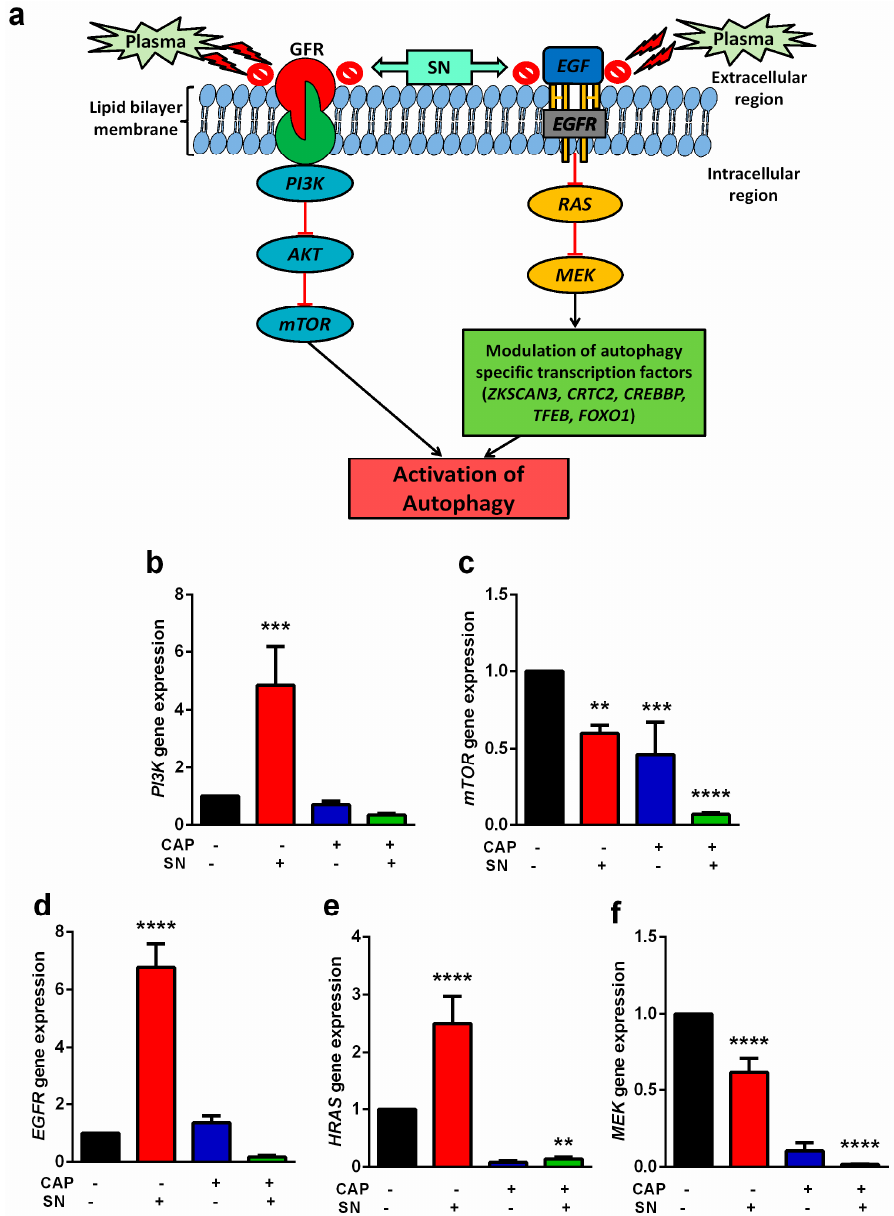
Figure 4 . ( a ) Illustration of the CAP and silymarin nanoemulsion (SN)-mediated hypothesis about the blockage of PI3K/AKT/mTOR and RAS/MEK pathways for the activation of autophagy. Gene analysis of the GFR -mediated downstream expression of the ( b ) PI3K gene and ( c ) mTOR gene, and gene analysis of the Epidermal Growth factor (EGF) -mediated downstream expression of the ( d ) EGFR gene, ( e ) HRAS gene, and ( f ) MEK gene. Data are the mean ± SE of three experiments. Statistical analysis was performed using a one-way ANOVA test followed by Dunnett’s test for comparisons. Each asterisk represents statistical differences between the treatment and control (** p < 0.01, *** p < 0.001, and **** p < 0.0001).